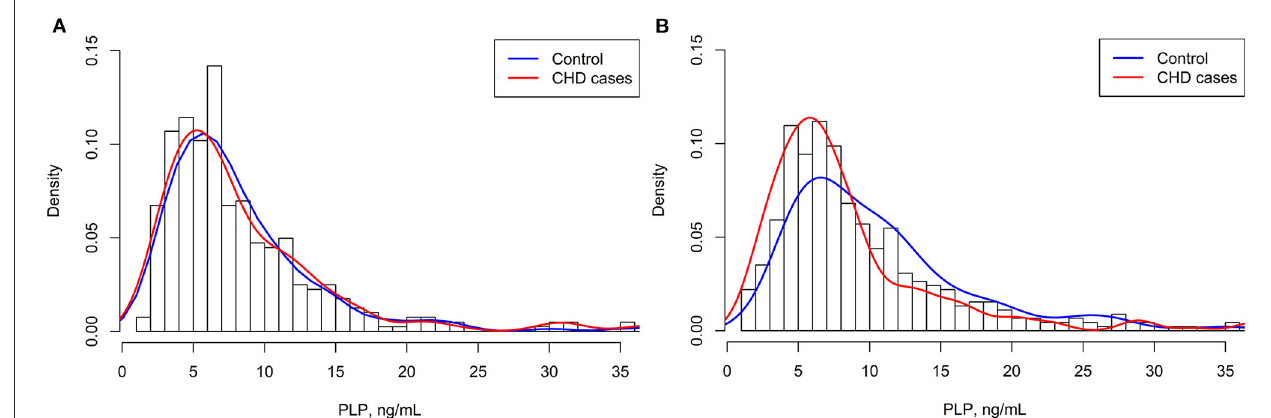
FIGURE 2 | Distributions of plasma PLP in CHD cases and controls. (A) Men; (B) Women.